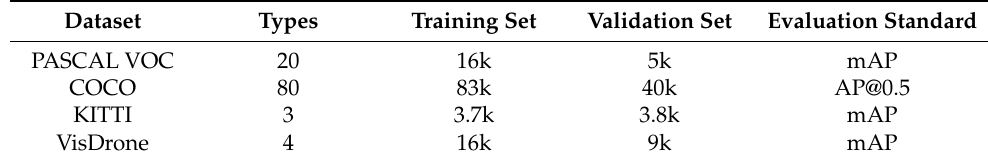
Table 3. The details of experimental